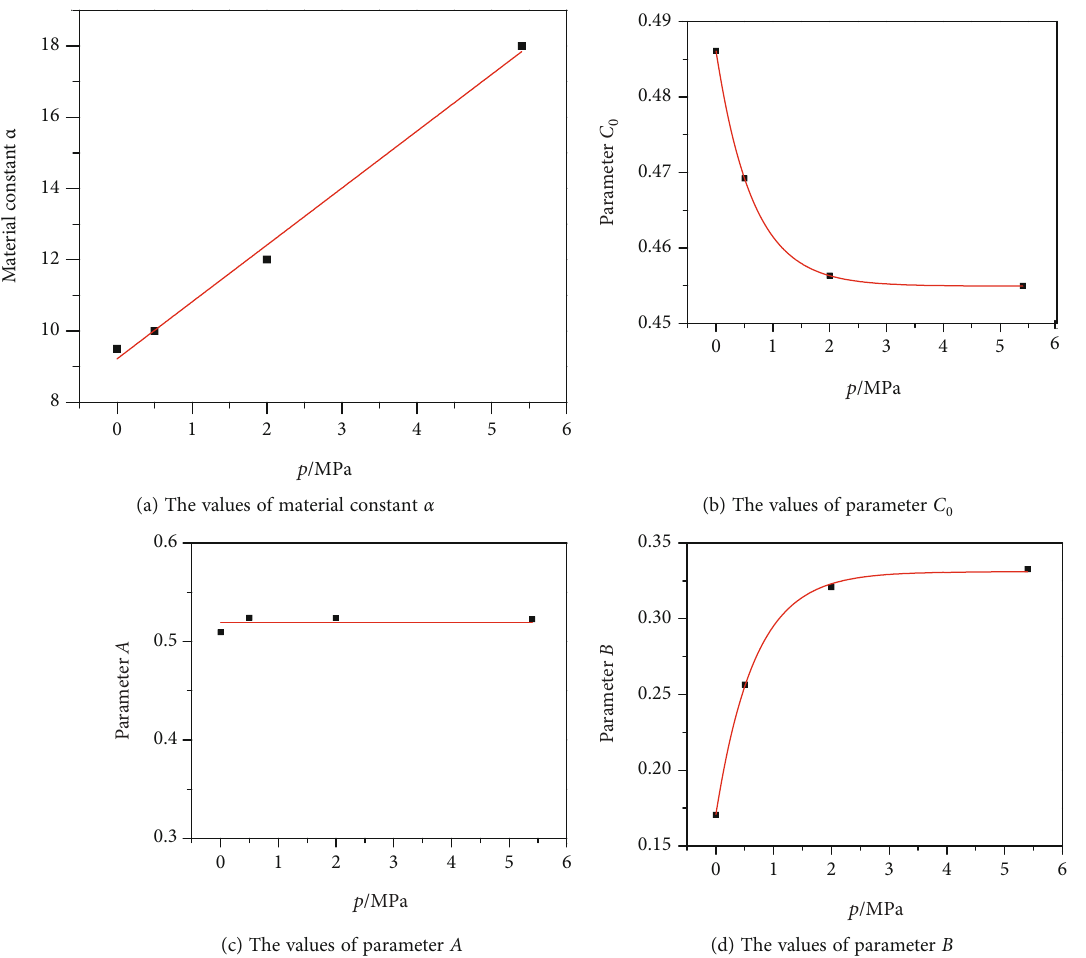
Figure 10: Model parameter fi tting